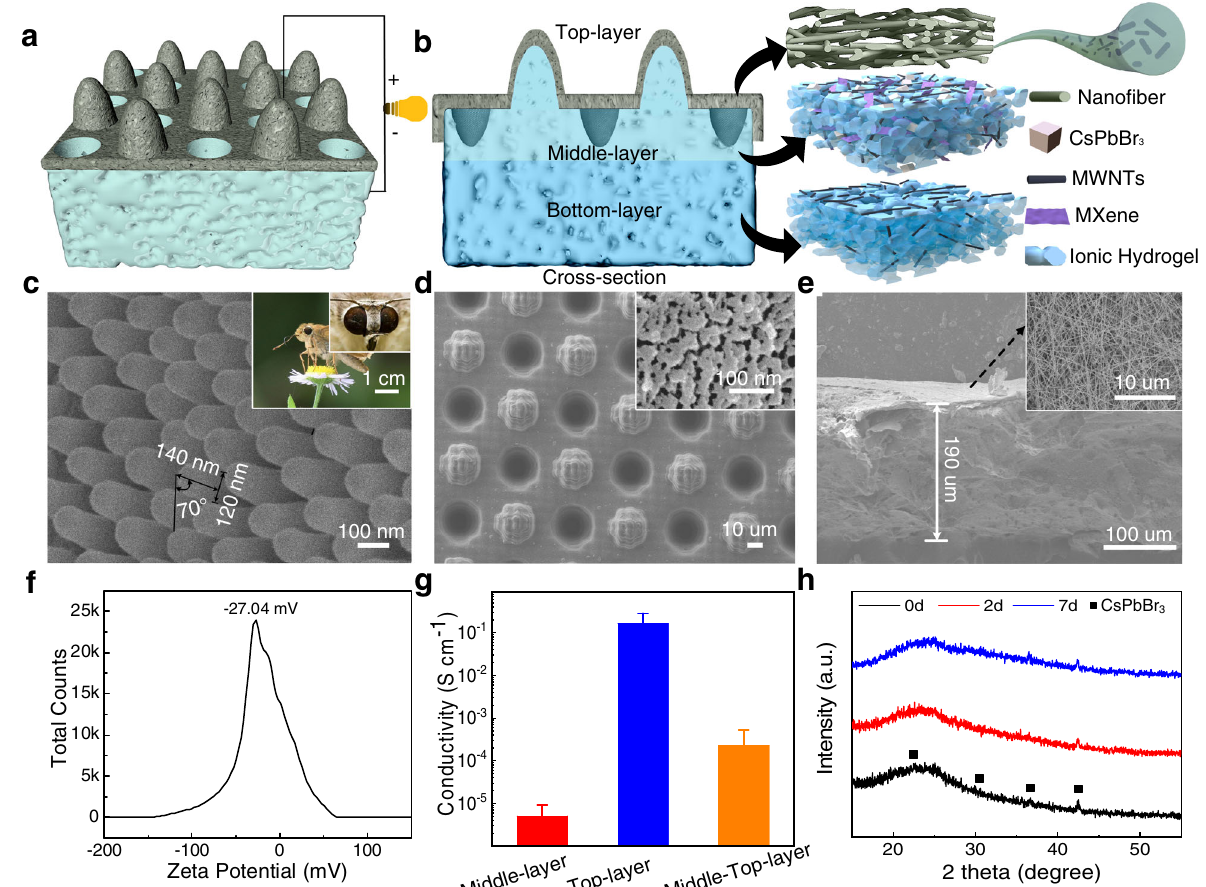
Fig. 1 | Design and characterization of the IENG. a Schematic diagram of struc- turaloftheIENGforall-in-oneevaporatortowardssimultaneouswaterevaporation andelectricitygeneration. b Schematicdiagramofthecompositionofafabricated IENG. c Morphologicalcharacteristicsofthemotheye. d Surfacemicrostructureof